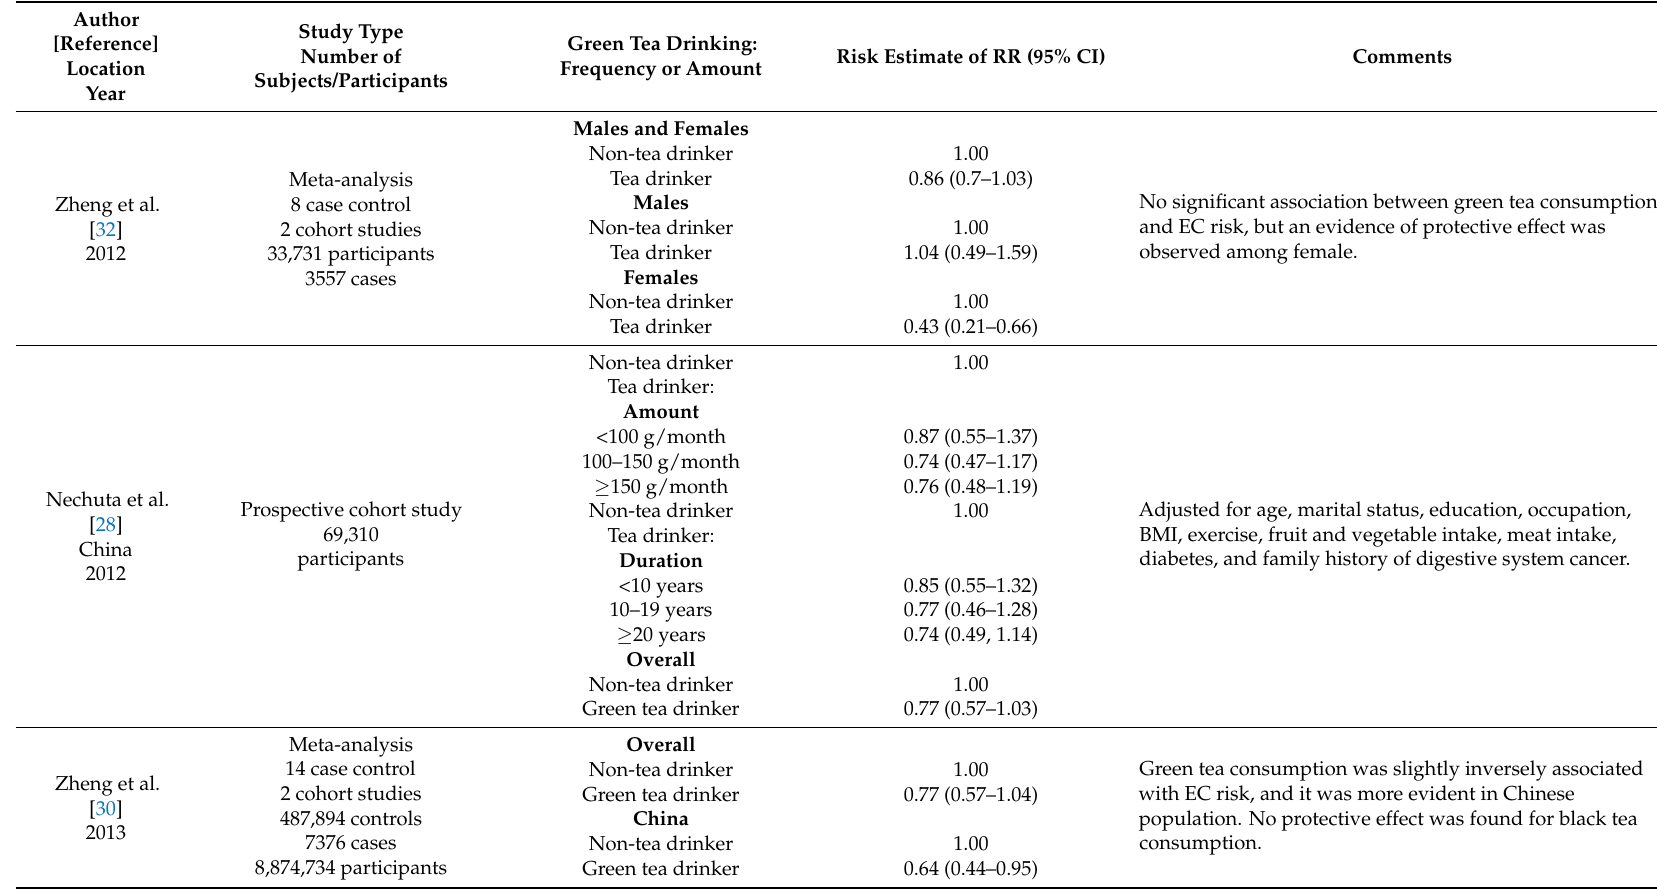
Table 2. Epidemiological studies of green tea drinking on EC